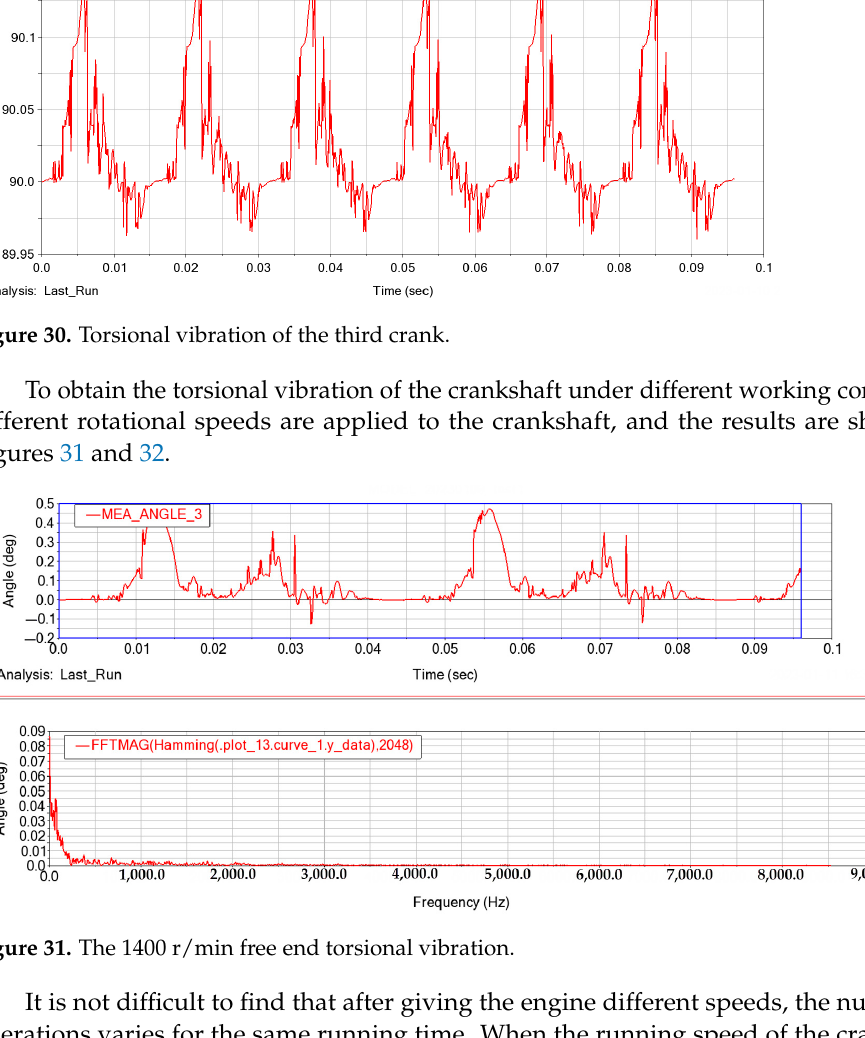
Figure 32. The 2600 r/min free end torsional vibration. 4. Conclusions The dynamics simulation of the crankshaft fl exible multi-body system is the basis to complete the optimization design of the engine crankshaft connecting rod system. In this paper, ANSYS workbench, ANSYS APDL and ADMAS View were used to simulate the dynamics of the fl exible system of a crankshaft connecting rod system of a three-cylinder gasoline engine. The following conclusions can be drawn: 1.